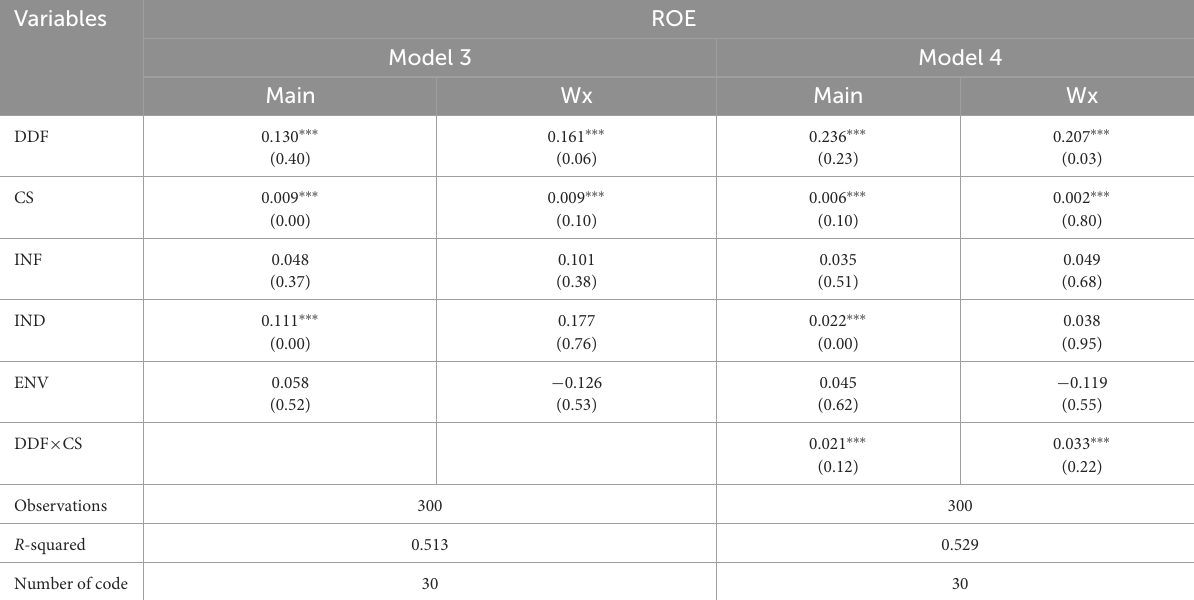
TABLE 6 Spatial Durbin model regression